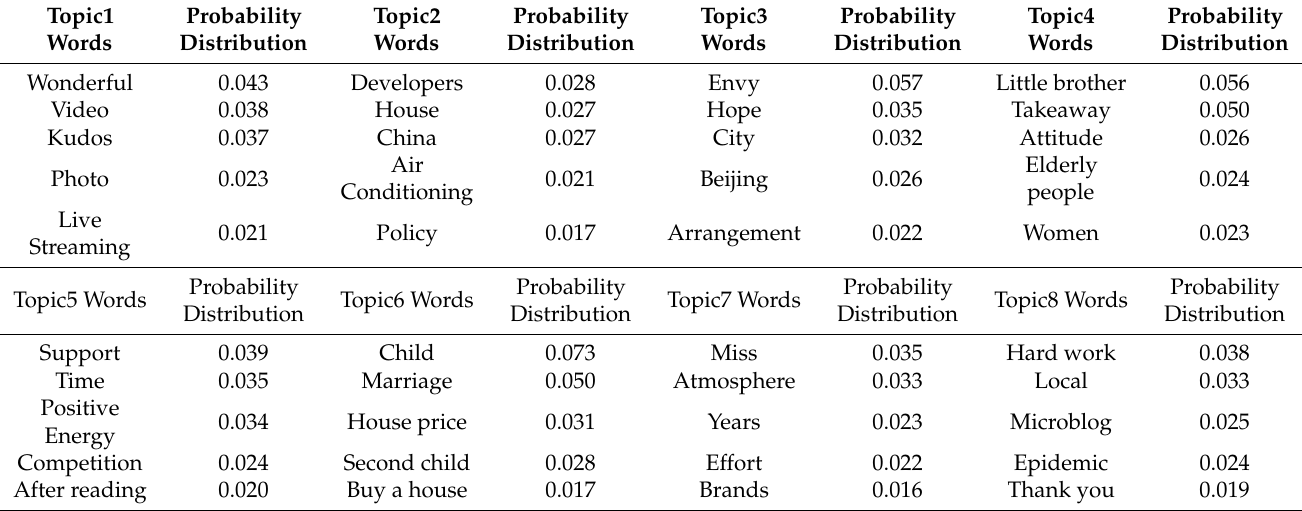
Table 15. B3 LDA theme model results.